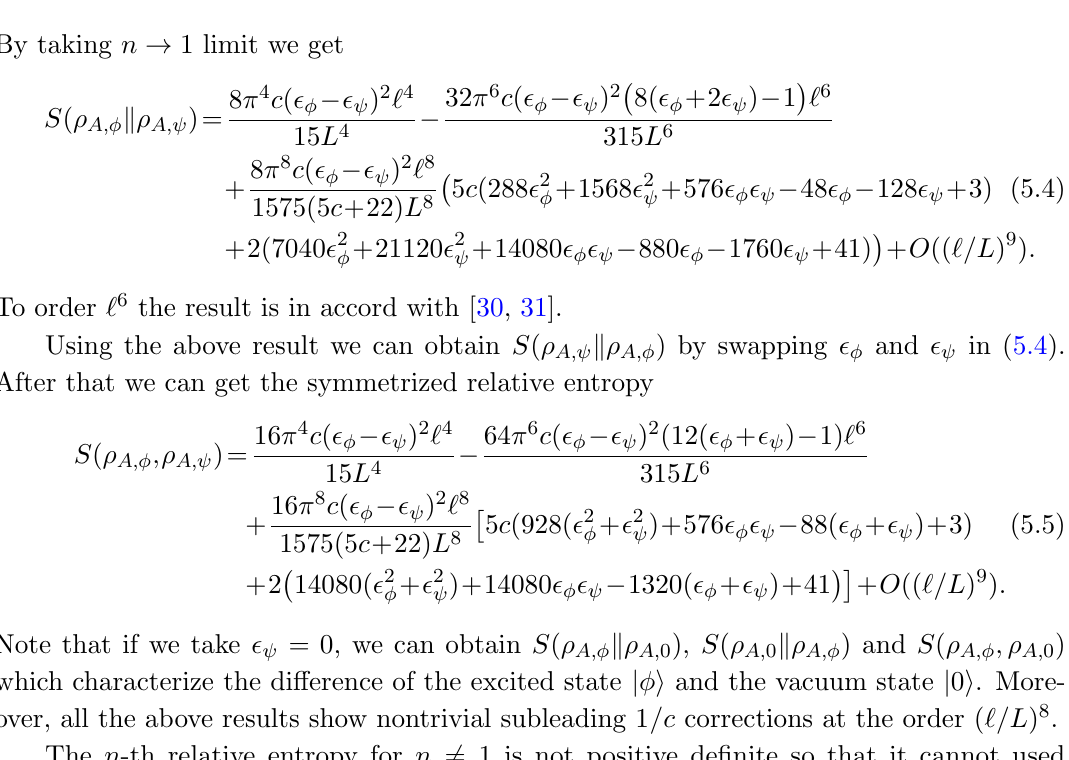
Figure 4 . The calculation of tr A ( (cid:26) A;(cid:30) (cid:26) n (cid:0) 1 and existing in the other n (cid:0) 1